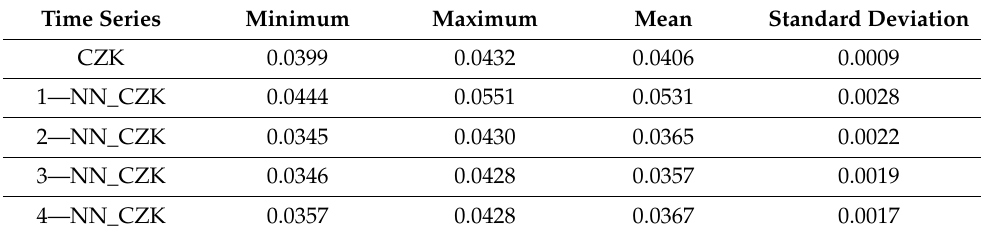
Table 6. Statistical characteristics of historical time series and predicted CZK prices.